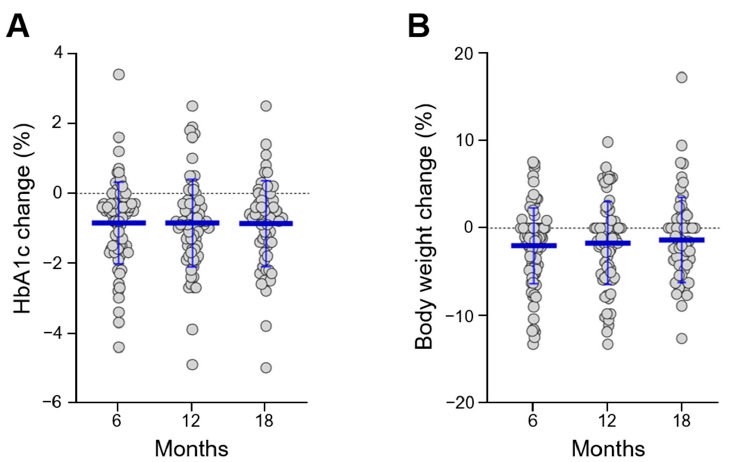
Figure 2. Longitudinal changes in HbA1c ( A ) and body weight ( B ) for up to 18 months. Longitudinal changes were calculated with respect to baseline values, as absolute (HbA1c) or relative (body weight) percentage differences.